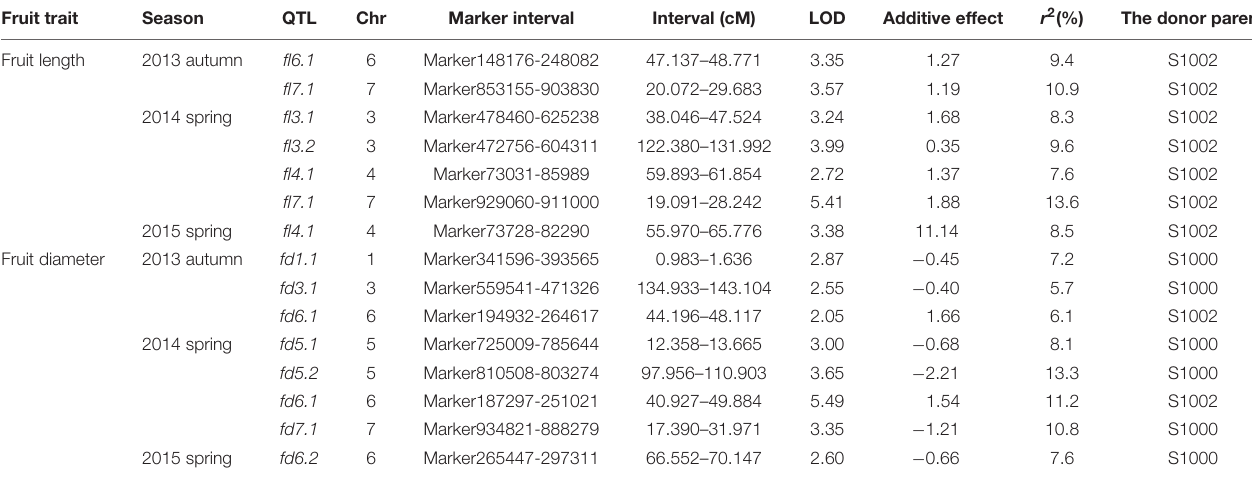
TABLE 4 | Quantitative trait loci (QTL) analysis of cucumber fruit length and diameter in F 3 families. Fruit